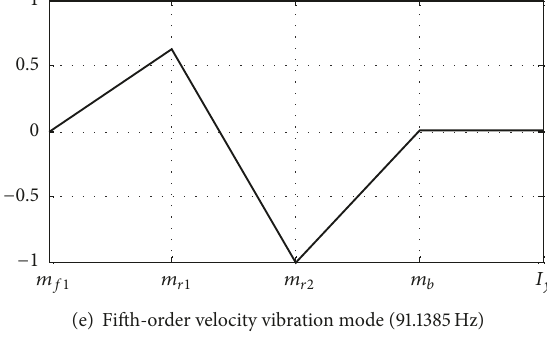
Figure 6: Vibration mode diagram of the